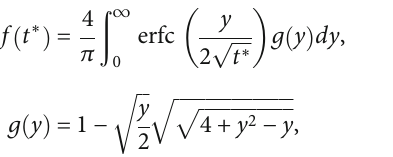
ffiffiffiffiffiffiffiffiffiffiffiffiffiffiffiffiffiffiffiffiffiffiffi ffiffiffiffiffiffiffiffiffiffiffiffiffiffiffiffiffiffi